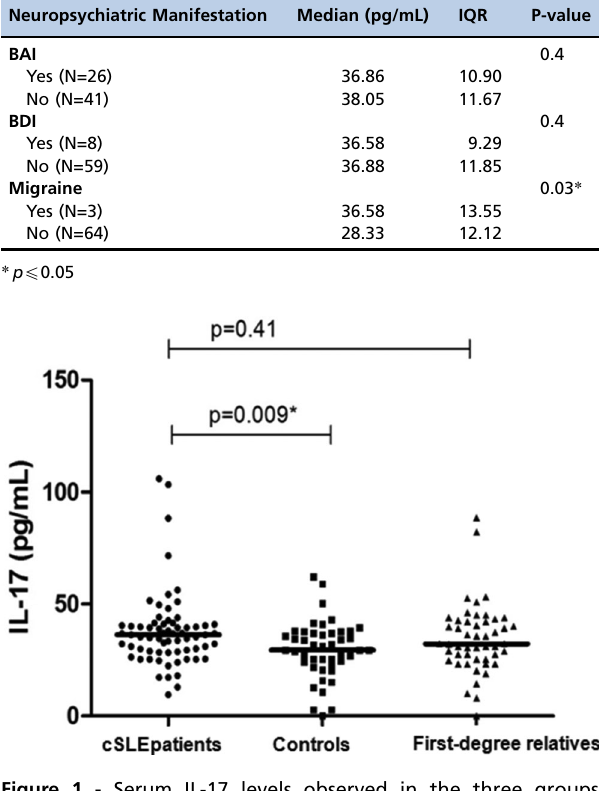
Figure 1 - Serum IL-17 levels observed in the three groups included in this